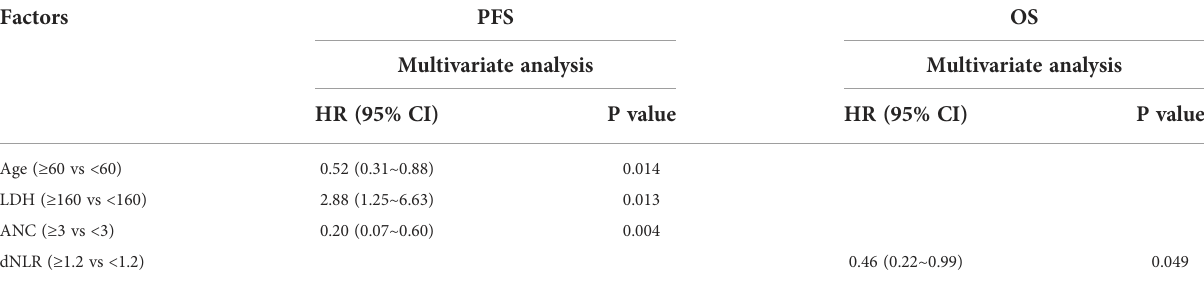
TABLE 3 Estimates for hazard ratios for progression-free survival and overall survival in the nivolumab group.